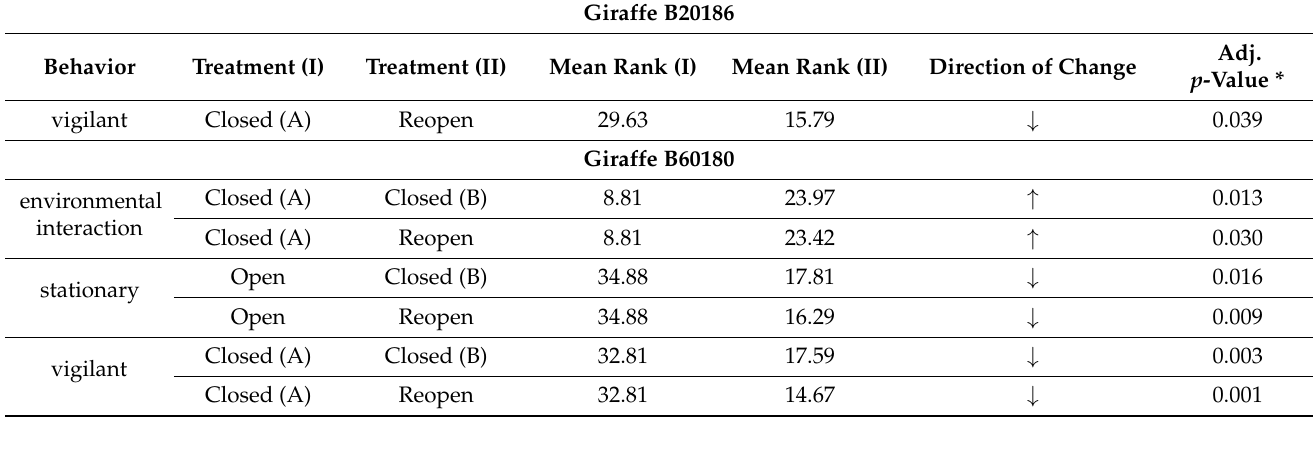
Table 7. Significant ( α = 0.95) results of the behavior engagement analysis for giraffe based on zoo opening status. Pairwise comparisons (Dunn 1984) were conducted on significant results from Kruskal–Wallis (H) tests. Asterisks ( * ) indicate adjusted p -values (Bonferroni correction for multiple comparisons).